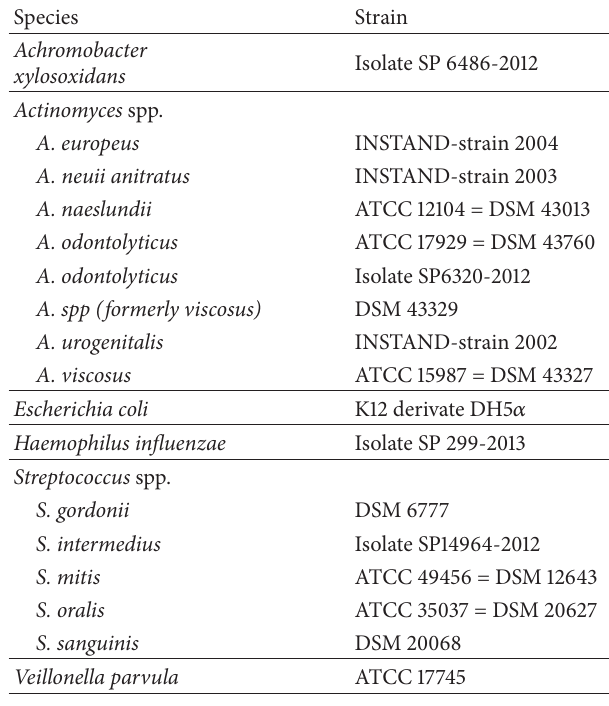
Table 3: Bacterial strains used for in vitro